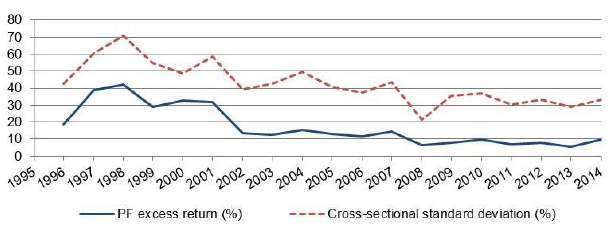
Figure 5: Small cap segment PF excess return and cross- sectional standard